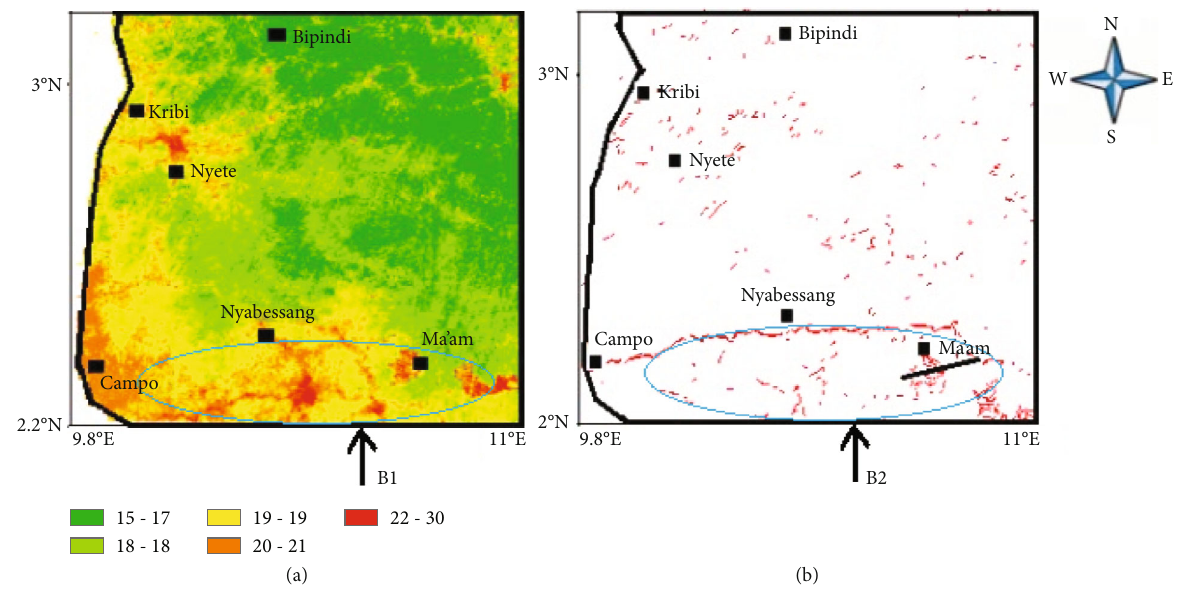
Figure 14: Comparative map. (a) LST. (b)